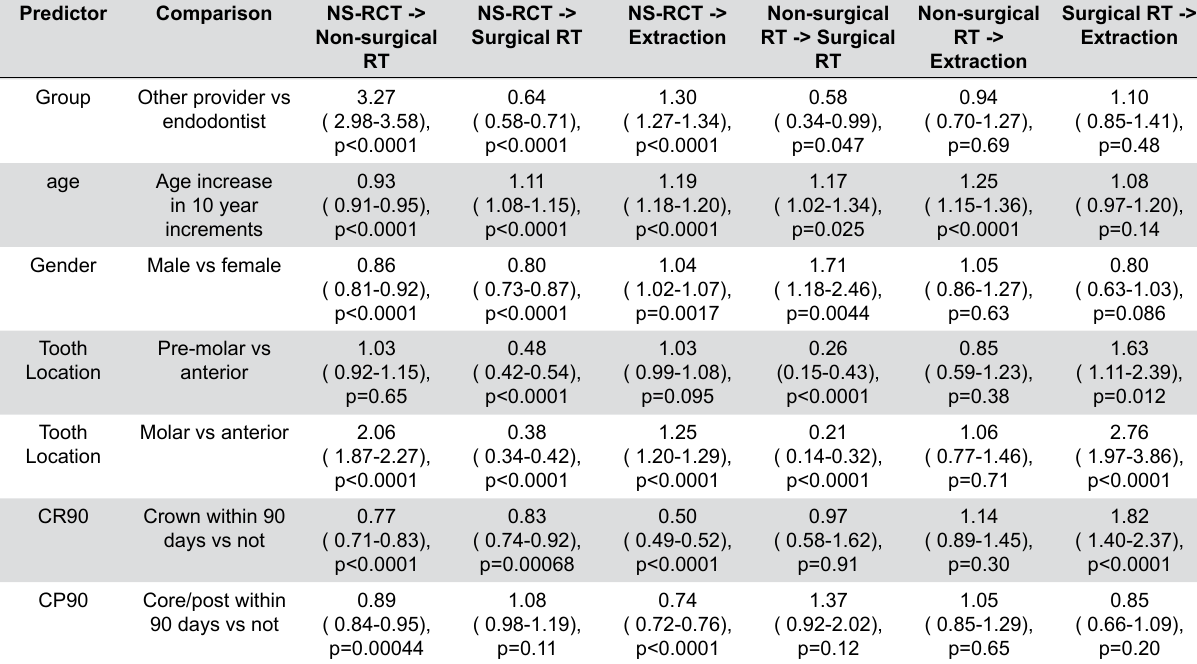
Table 4- Proportional hazards model to estimate the effect of provider adjusting for other covariates on